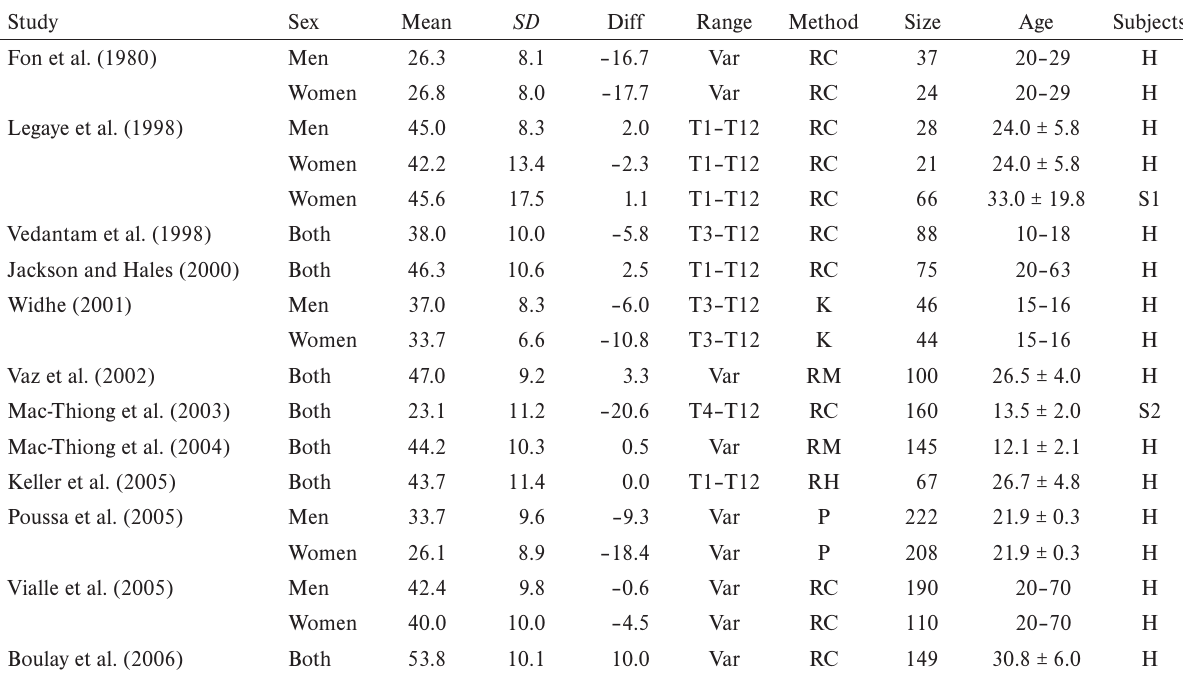
Review of thoracic kyphosis curvatures(in degrees) in other studies